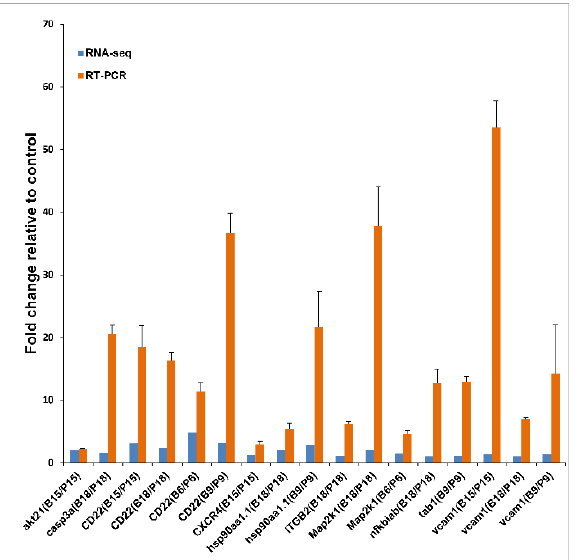
Figure 8. Validation of RNA-seq results using RT-PCR. The transcript expression levels of the selected genes were normalized to that of the β -actin gene.